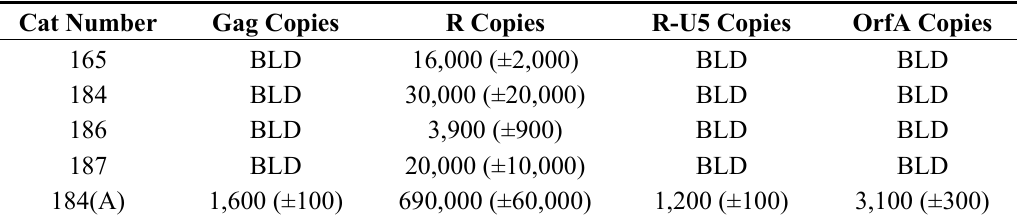
Table 2. Real-time PCR amplifications of cDNA isolated from FIV-infected CD4+ T-